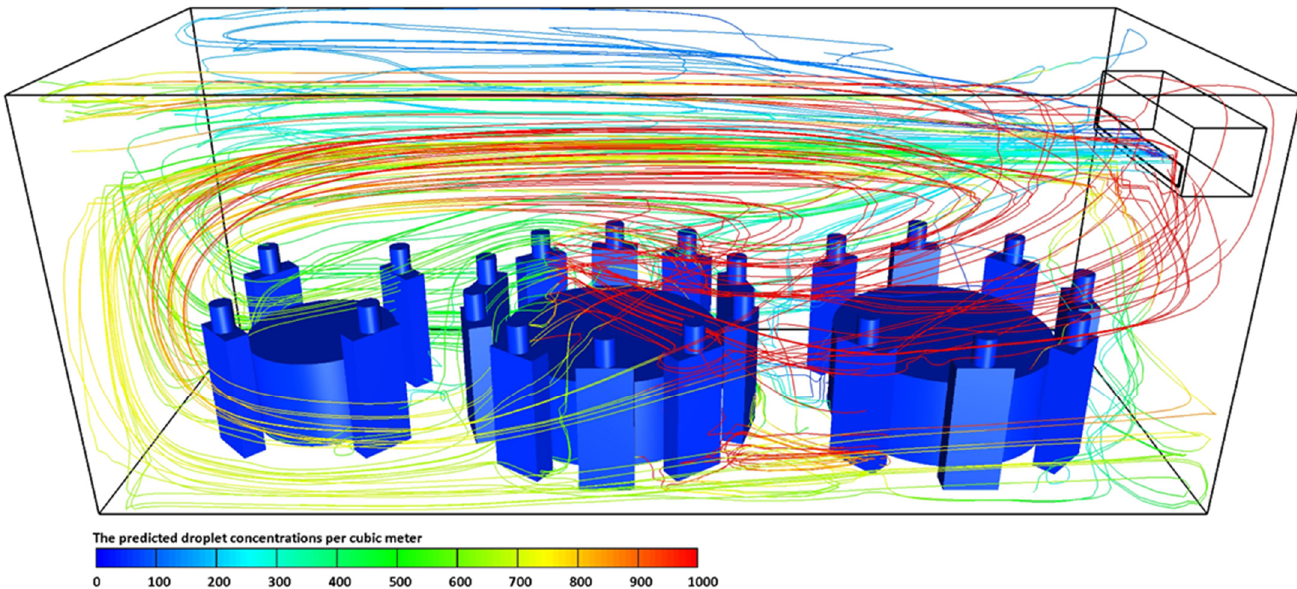
Figure 5. The predicted droplet concentrations per cubic meter exhaled from index case (T2C1) at t = 4500 s for case-1.